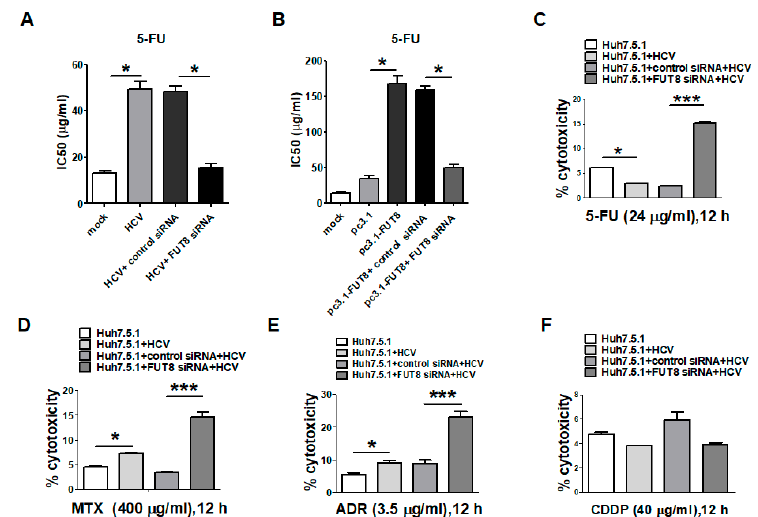
Figure 4. Silencing of FUT8 enhanced the chemosensitivity of Huh7.5.1 Cells. The effect of knockdown ( A ) or overexpression of FUT8 ( B ) on the chemosensitivity of 5-FU was also determined using the LDH assay. ( C – F ) The LDH release assay was used to analyze the cytotoxicity of the 5-FU / MTX / ADR / CDDP in HCVcc-infected Huh7.5.1 cells by knockdown of FUT8.